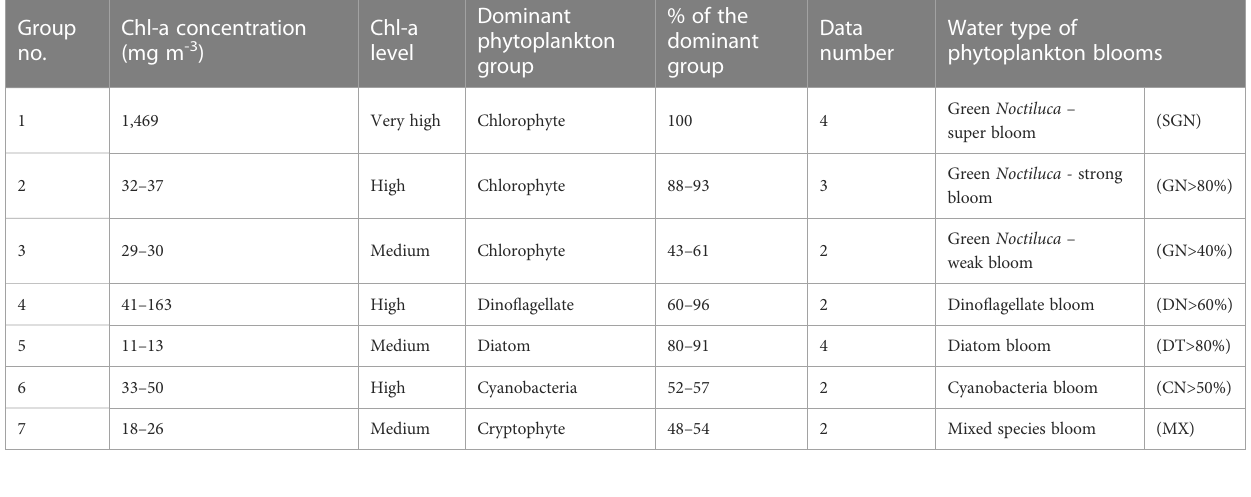
TABLE 1 A summary of the. R rs categorization criteria for algal bloom waters based on in situ data obtained during 2017 – 2019.